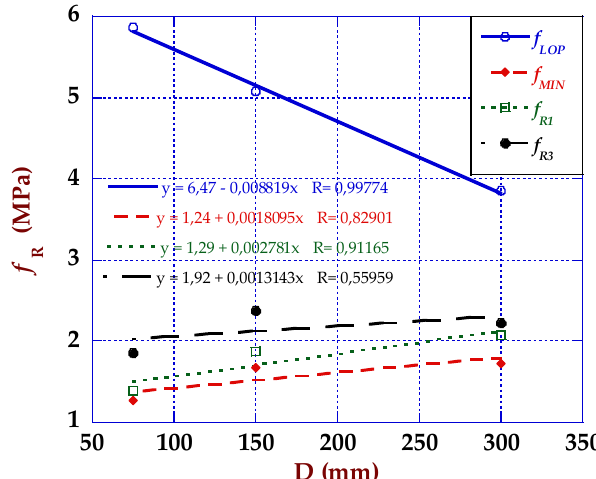
Figure 10. Plots of average values of proportionality limit strength ( f LOP ), minimum strength at the end of discharging branch ( f MIN ), CMOD opening of 0.5 mm ( f R1 ) and CMOD of 2.5 mm ( f R3 ) versus the total specimen depth D.